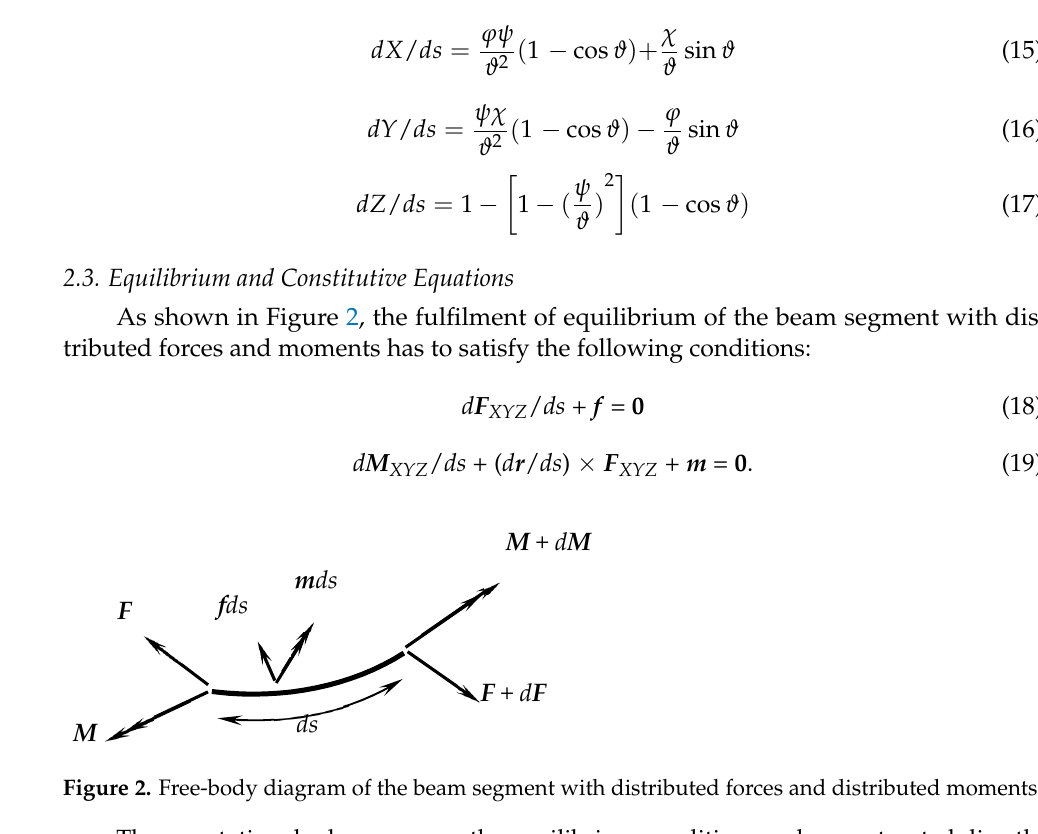
Figure 2. Free-body diagram of the beam segment with distributed forces and distributed moments.